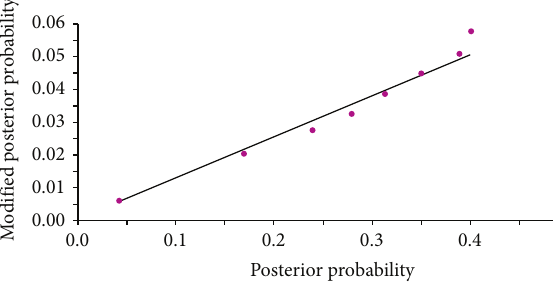
Figure 6: Modification on posterior probabilities.